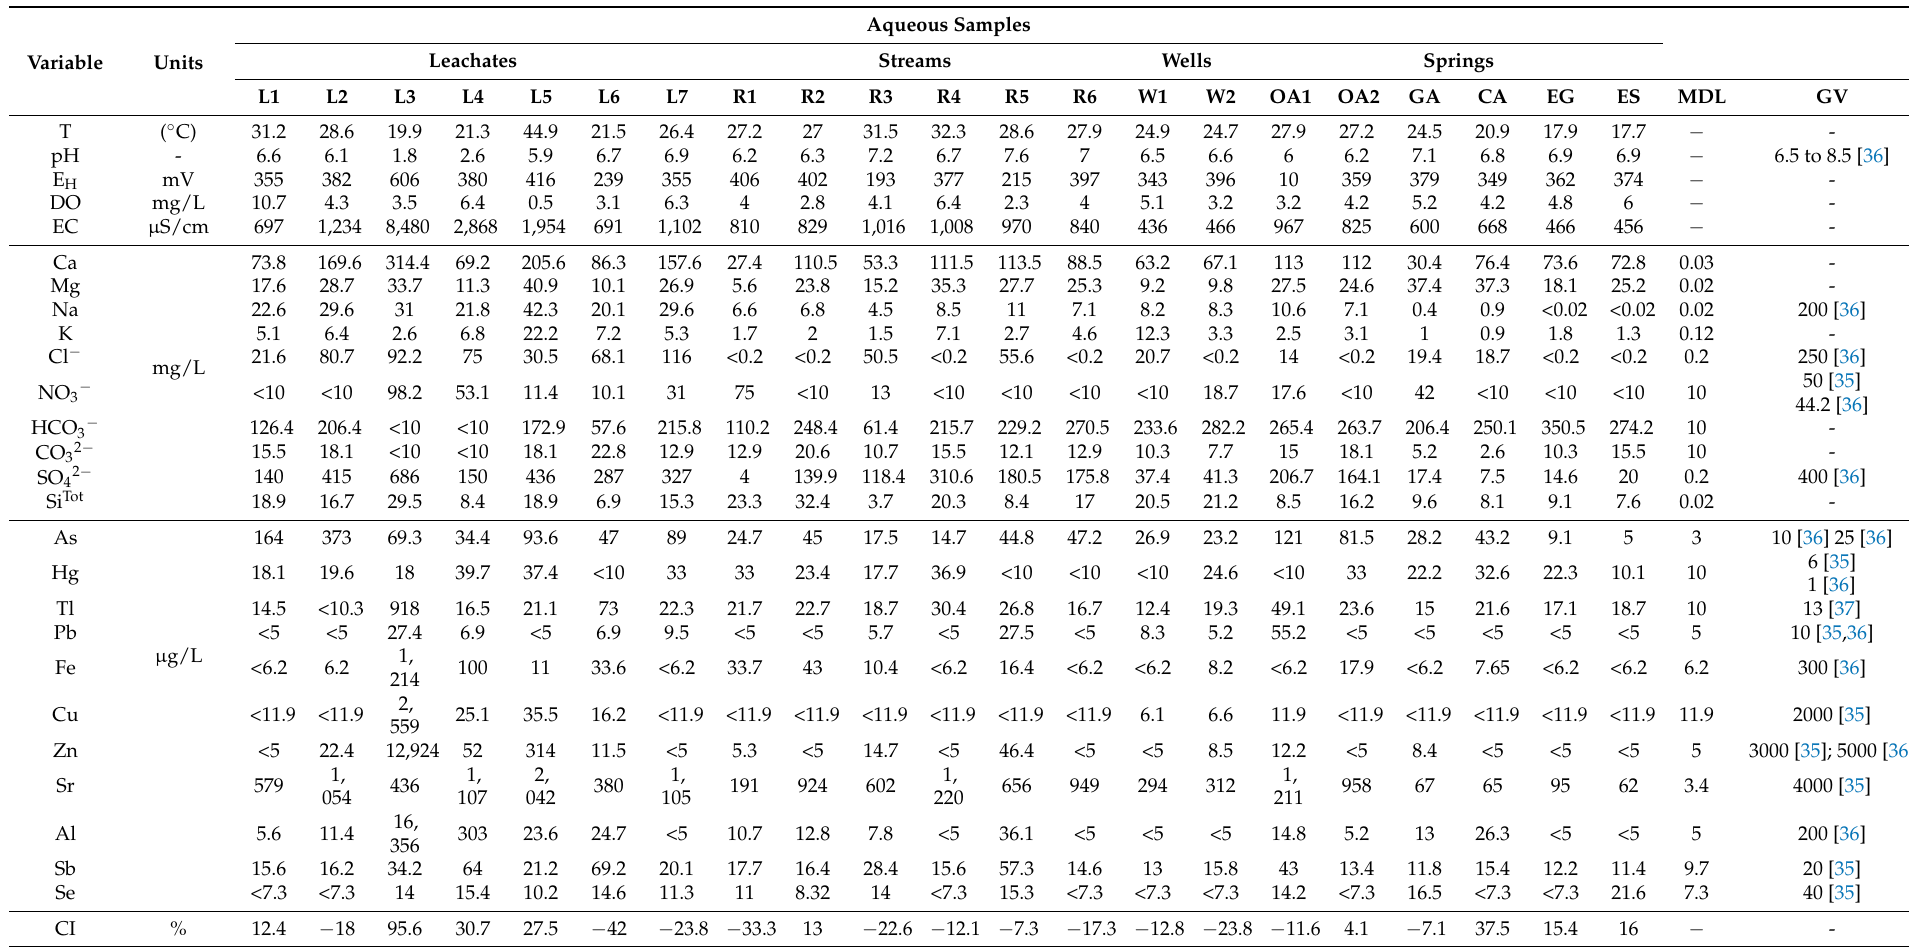
Table 2. Physicochemical parameters and chemical concentrations of cations, anions, and trace elements in different types of aqueous samples collected in the study area.